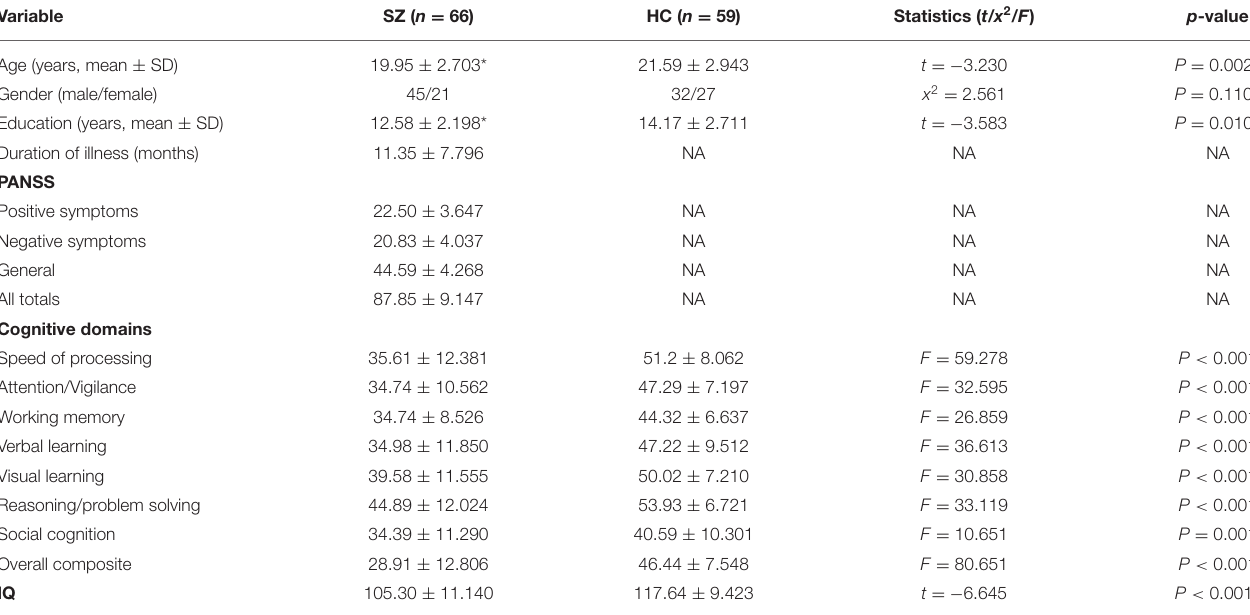
TABLE 1 | Demographic data, the MCCB scores, IQ, and clinical information in patients and HC.